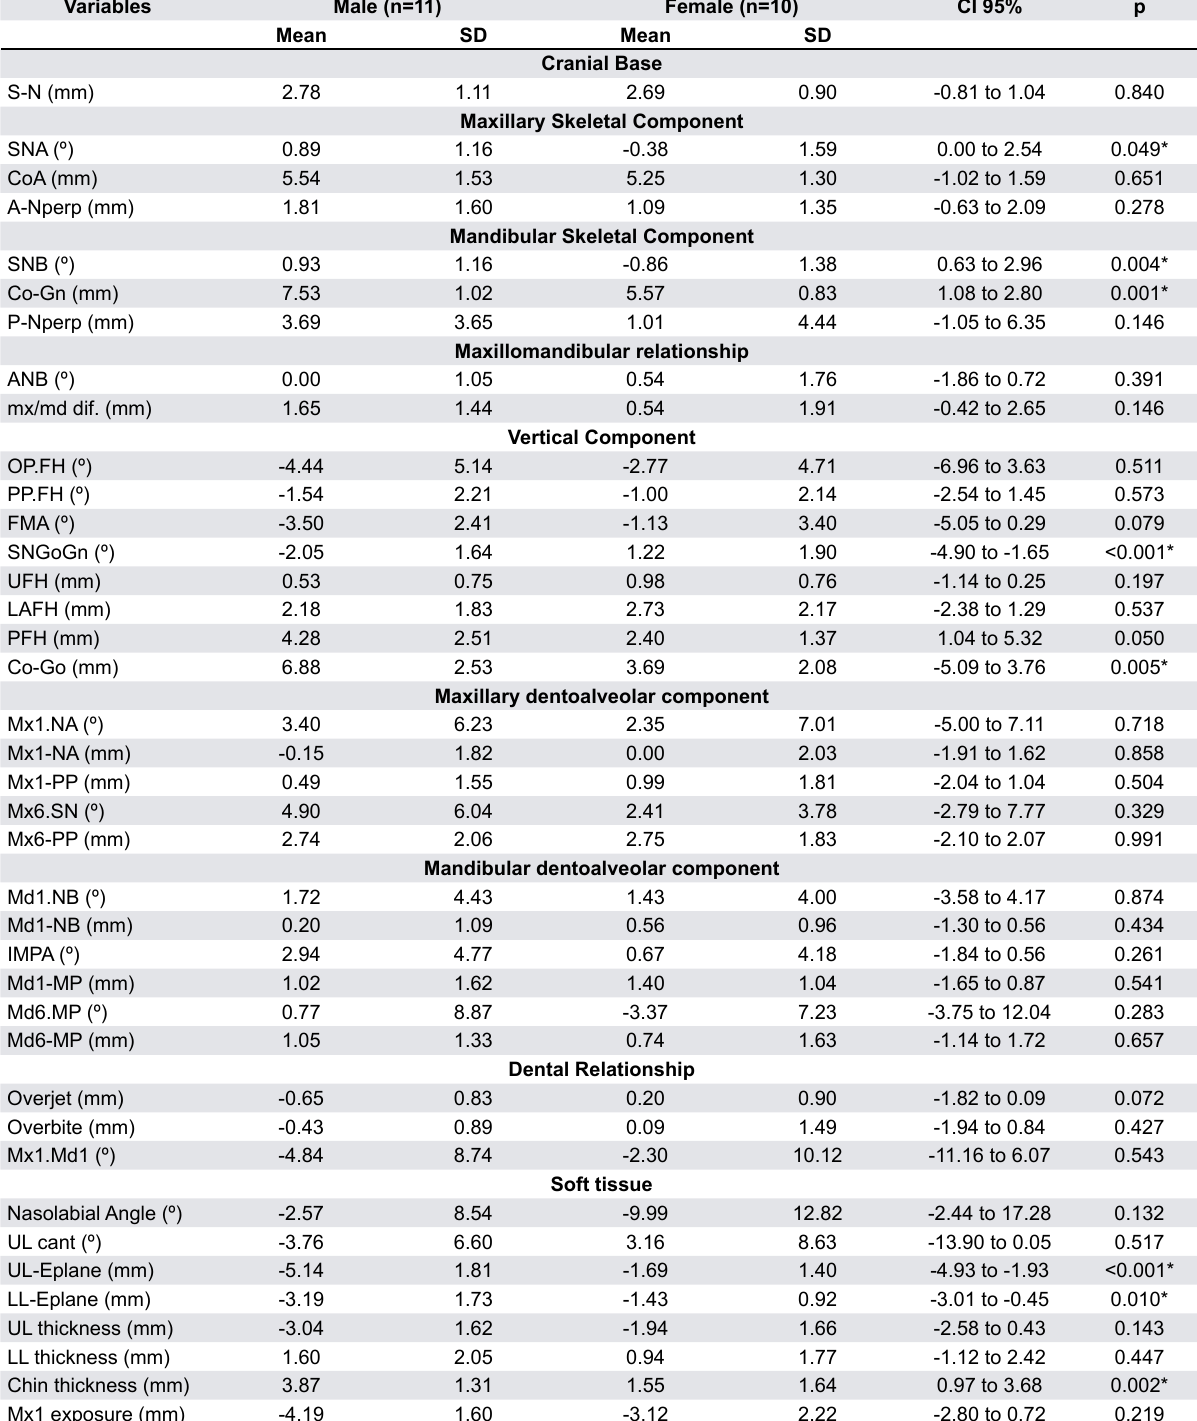
Table 3- Male and female change comparisons